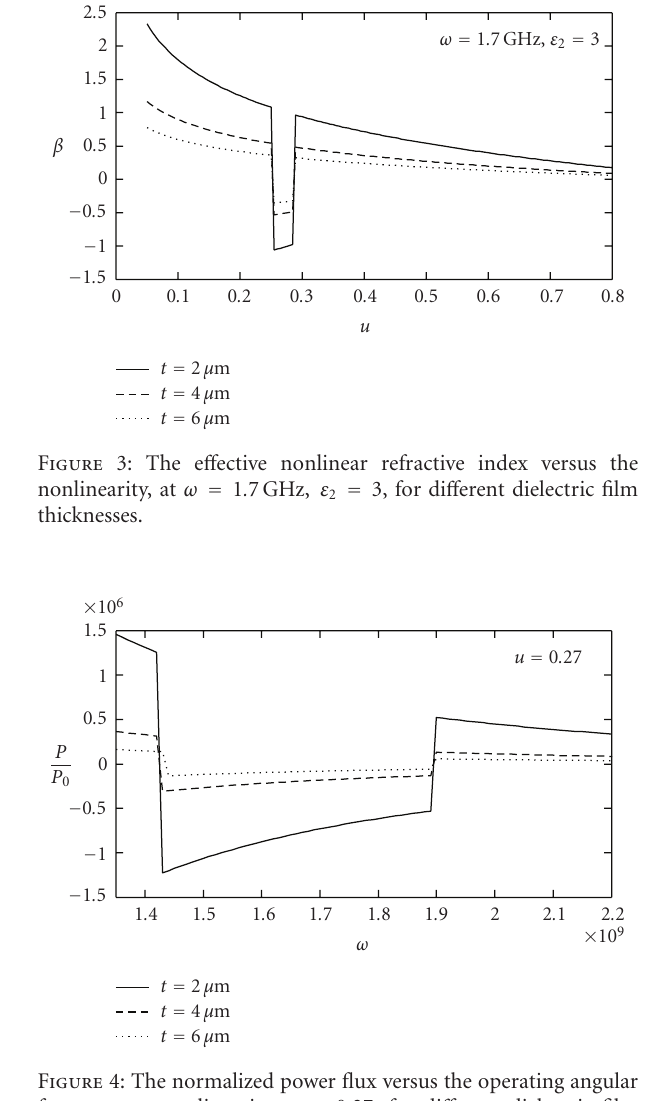
Figure 4: The normalized power flux versus the operating angular frequency at nonlinearity u = 0 . 27, for di ff erent dielectric film